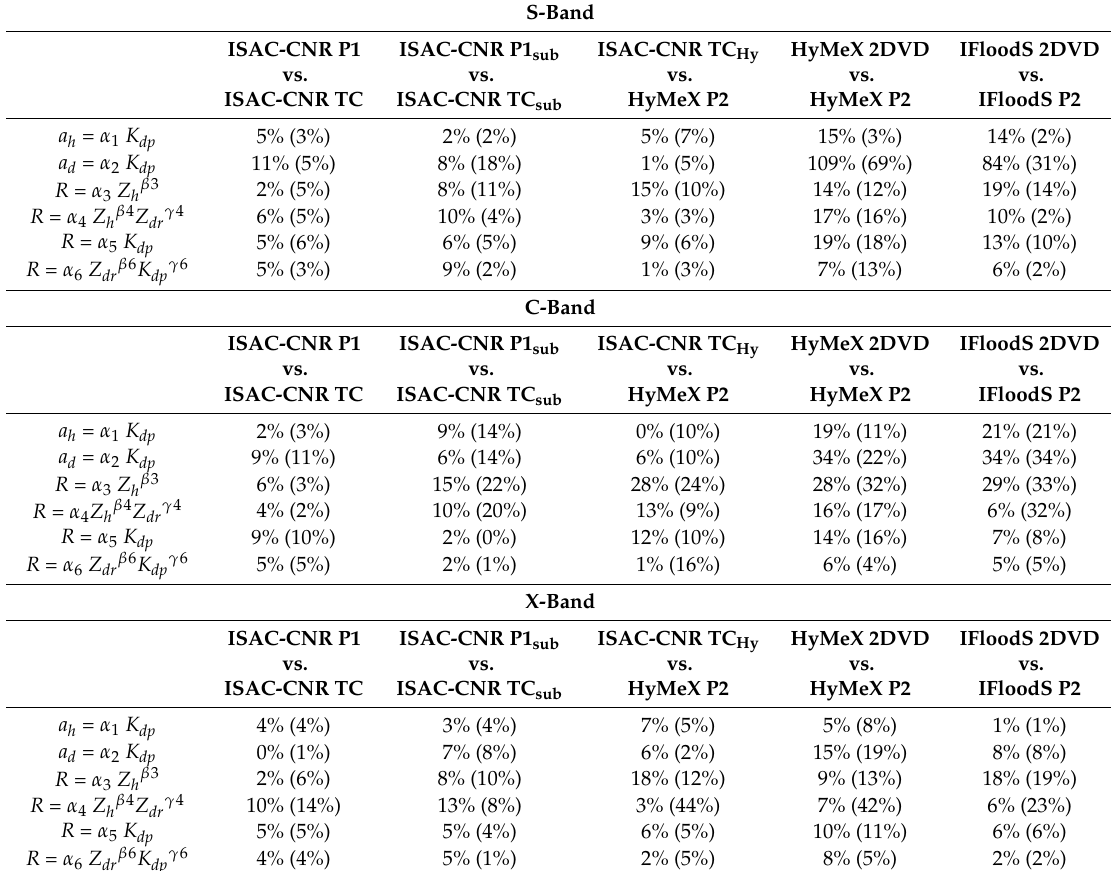
Table 4. For each frequency, the values of NMAE (in %) obtained by pairwise comparison of the parameters estimated through the weather radar algorithm established from 1-min DSDs collected by the different devices are reported, as described in the title of each column of the table. The values in brackets refer to the NMAE obtained using the SIFT